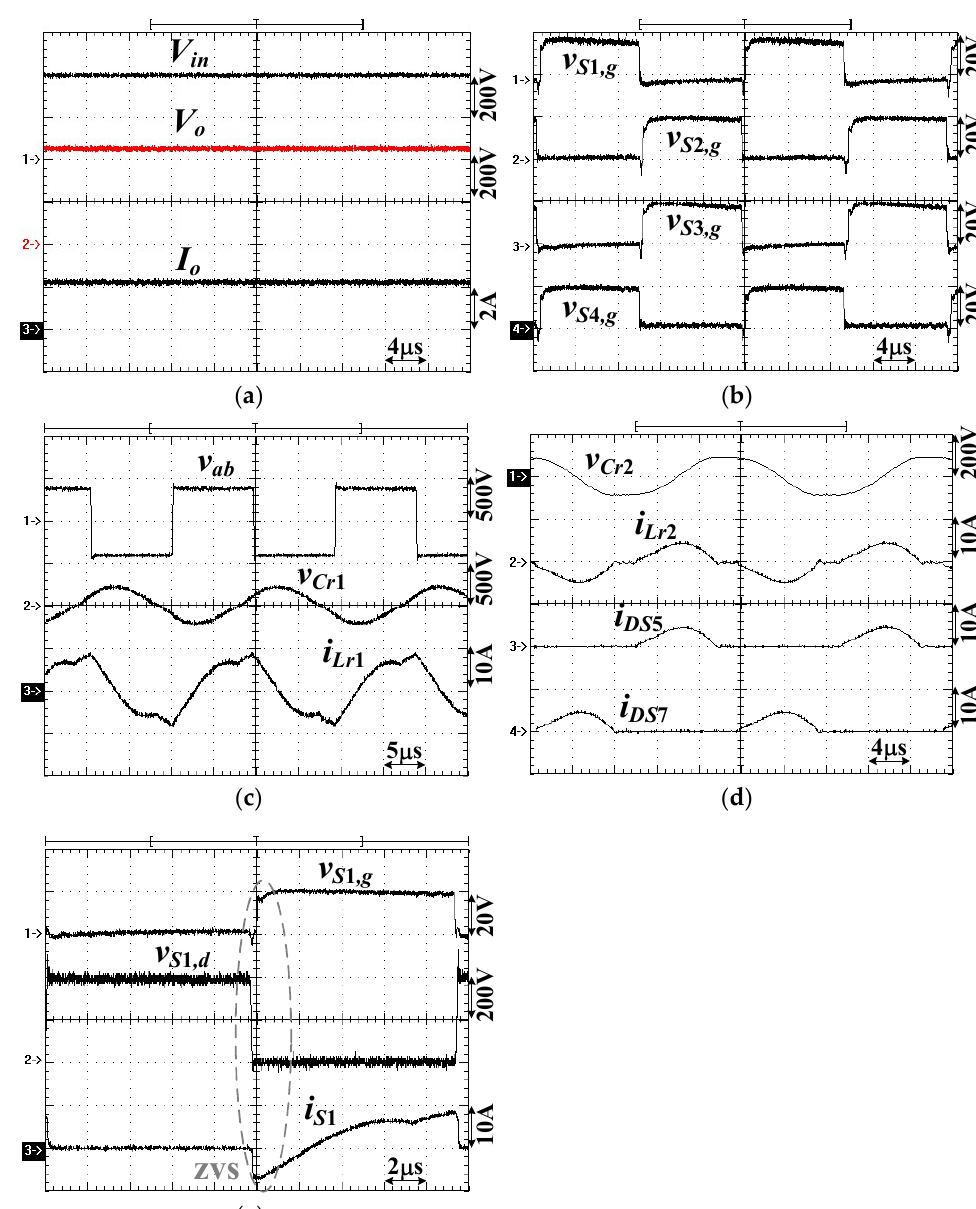
Figure 12. Experimental waveform of the proposed converter at V o = 310 V and the rated load current ( a ) V in , V o , and I o ; ( b ) v S 1, g , v S 2, g , v Cr 1 , and i Lr 1 ; ( c ) i Lr 2 , v Cr 2 , i DS 5 , and i DS 7 ; ( d ) v S 1, g , v S 1, d , and i S 1 .